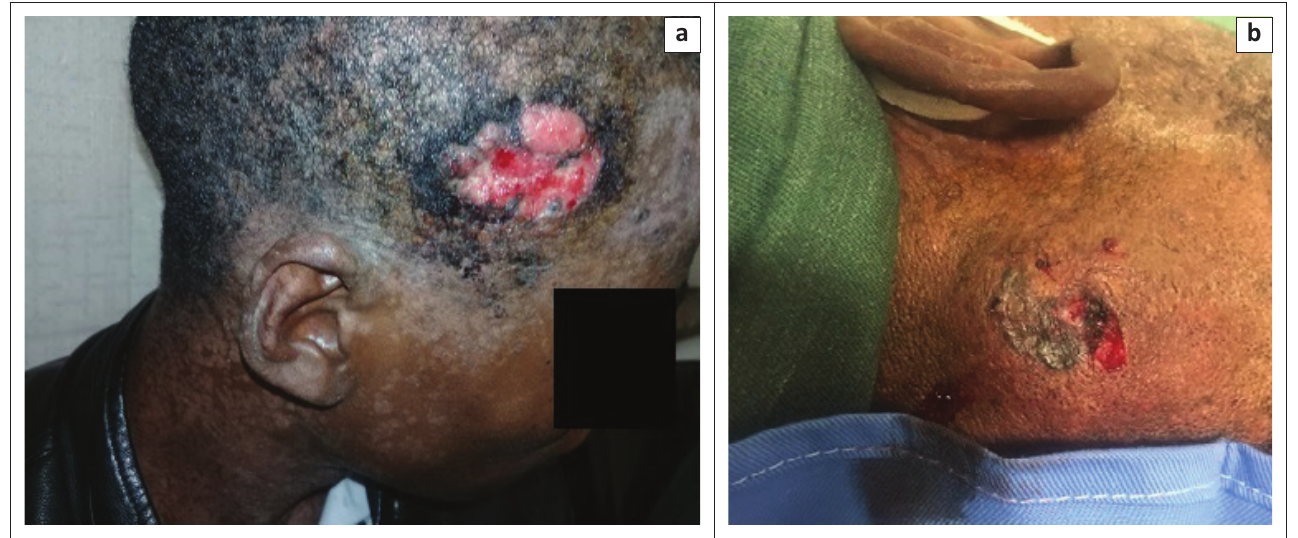
FIGURE 2: (a) Right parietal scalp ulcer; (b) Left occipital lesion, following a wedge